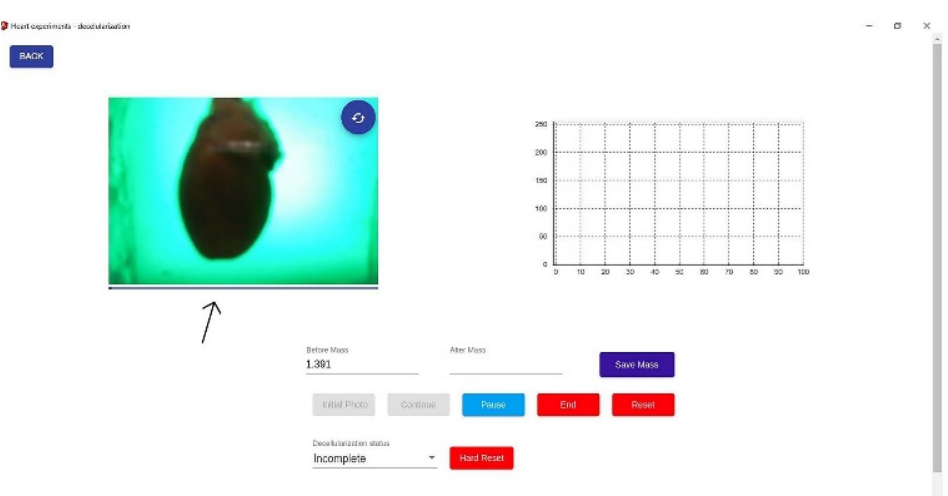
Figure 4. Application programming Interface. Once the process begins, the graphic of the live spec- trometer metric can be seen on the upper right side. The progress bar below the camera stream is the classification metric (built with a Deep Convolutional Neural Network model) that shows the progress of the decellularization process (black arrow). The buttons below control the session and allow different commands such as starting, pausing, and ending. Resetting the position of the step- per motor to the initial phase is also possible. The weight of each rat heart is introduced in the pro- gram before starting the decellularization process.